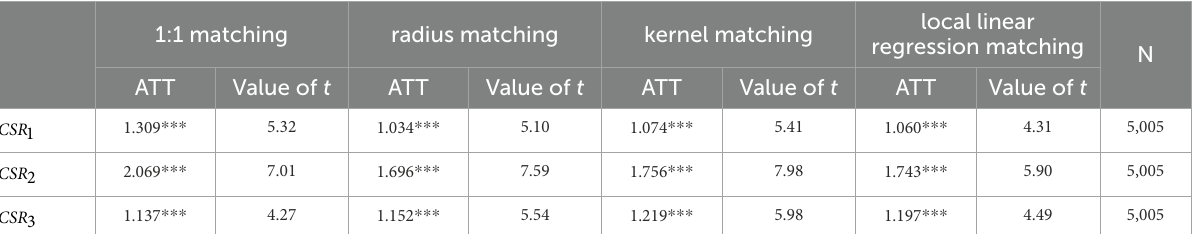
TABLE 7 Propensity score matching.